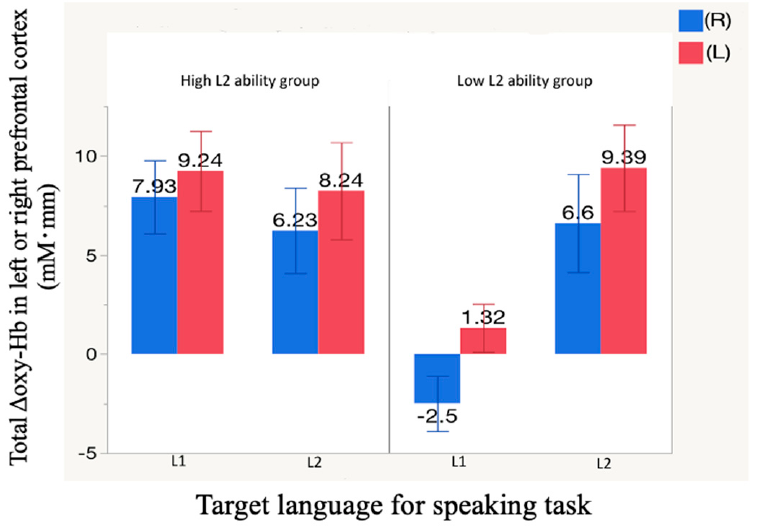
Figure 6. Values of ∆ oxy-Hb in the left and right prefrontal cortex of native speakers of Mandarin by L2 ability.